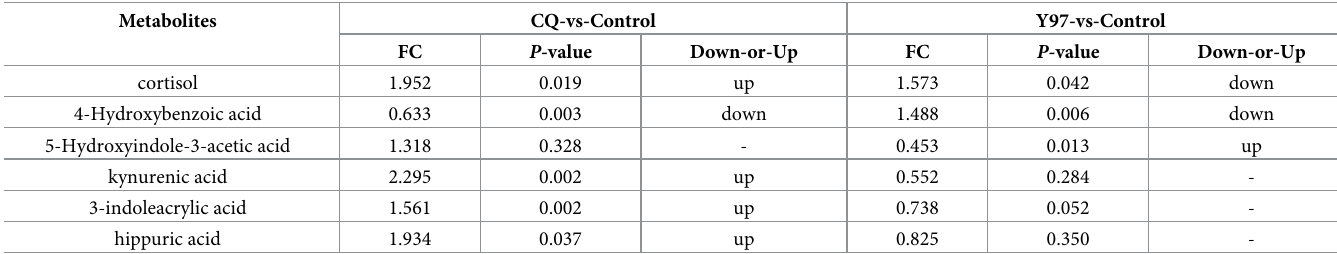
Table 3. Some differential metabolites in serum of three groups.